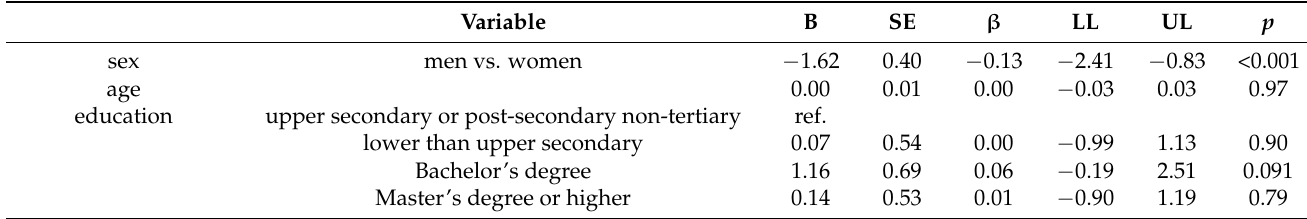
Table 3. Univariate linear regression modelling for